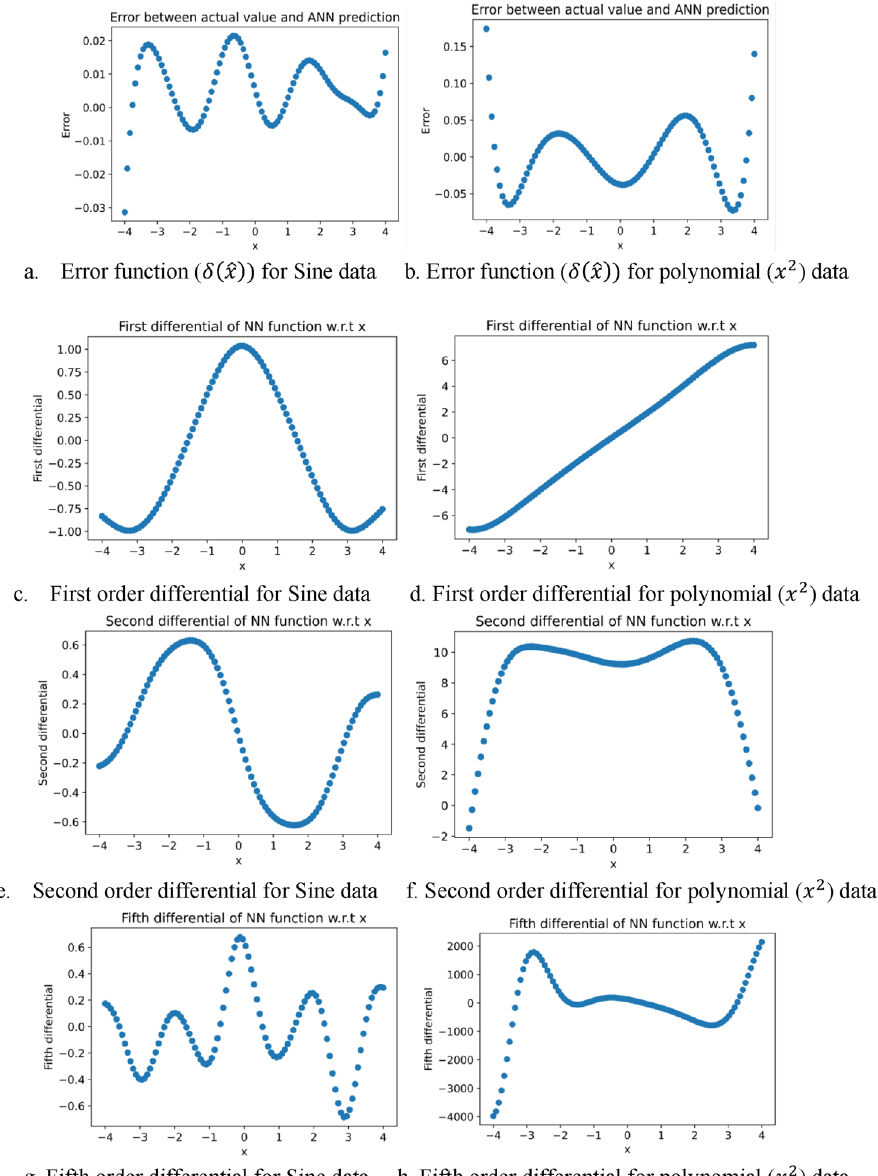
Fig. 3 Results of ANN output function using tanh activation